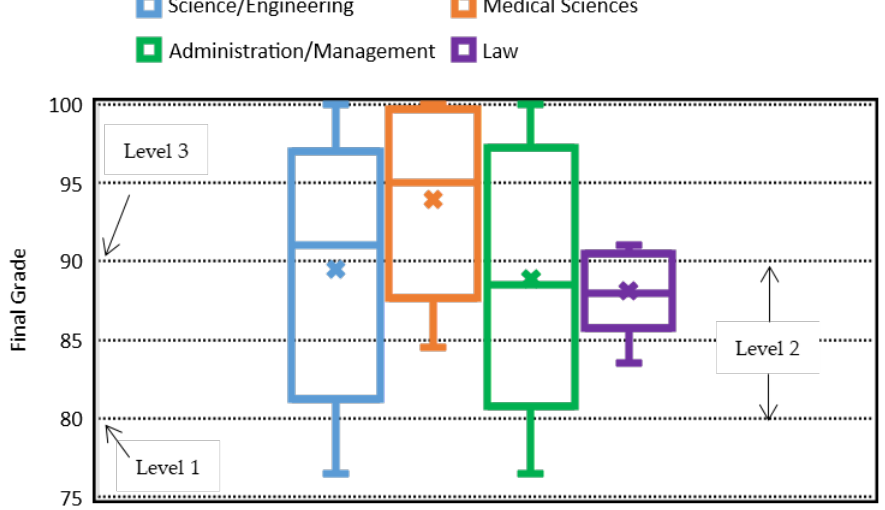
Figure 12. Box and whisker plot on the final grade vs. degree-program group (1 = Science/Engineering, 2 = Medical Sciences, 3 = Administration/Management and 4 = Law) for the EFR competency.